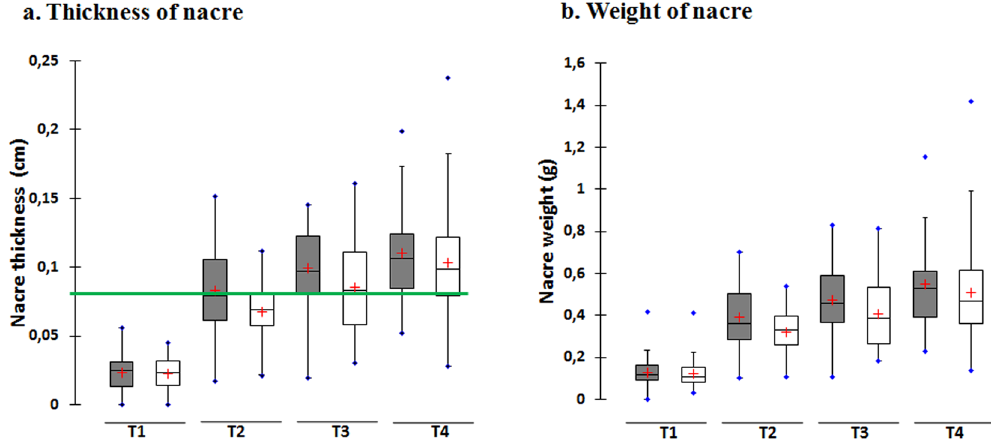
Figure 1. Box-plot showing: ( a ) thickness of nacre (cm) and ( b ). weight of nacre ( g ) on cultured pearls produced using graft tissue from each of the P. margaritifera donor phenotypes at each harvest time (T1 corresponds to 3 months of culture, T2 to 6 months, T3 to 9 months and T4 to 12 months). The box-plots in grey represent data for the QL donor phenotype and box-plots in white represent data for the TL donor phenotype. Each box-plot has the following 6 elements: 1) mean (“ + ” cross in the box-plot); 2) median (solid bar in the box-plot); 3) 25 th to 75 th percentile (rectangular box); 4) 1.5 * interquartile range (non-outlier range of the box whiskers); 5) minimum and maximum values (extreme dots); and 6) outlier values (outside box whiskers). The green line on the nacre thickness box plot corresponds to the minimum nacre thickness necessary for pearl export outside French Polynesia (0.08 cm) (N =